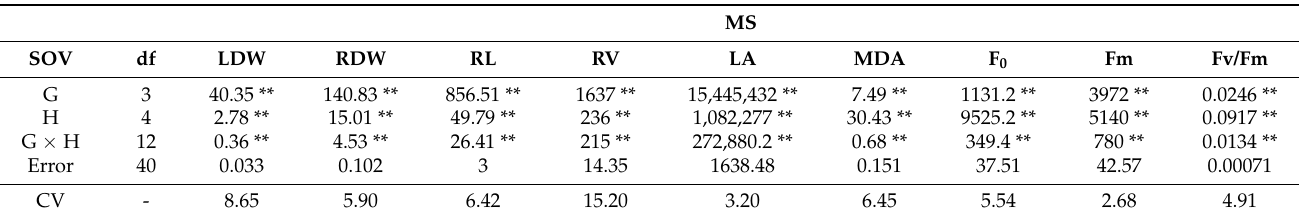
Table 1. Analysis of variance for morphophysiological traits of four Echinacea cultivars (G) evaluated at five doses of metribuzin